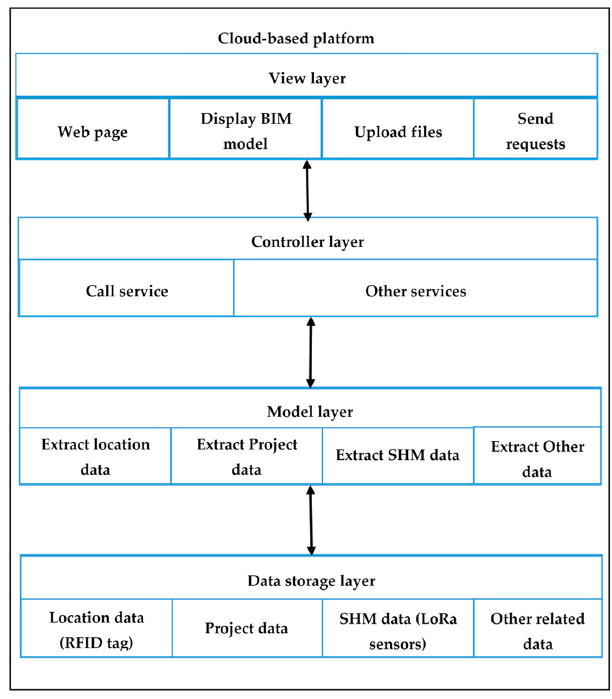
Figure 8. The four layers of the cloud-based BIM model.